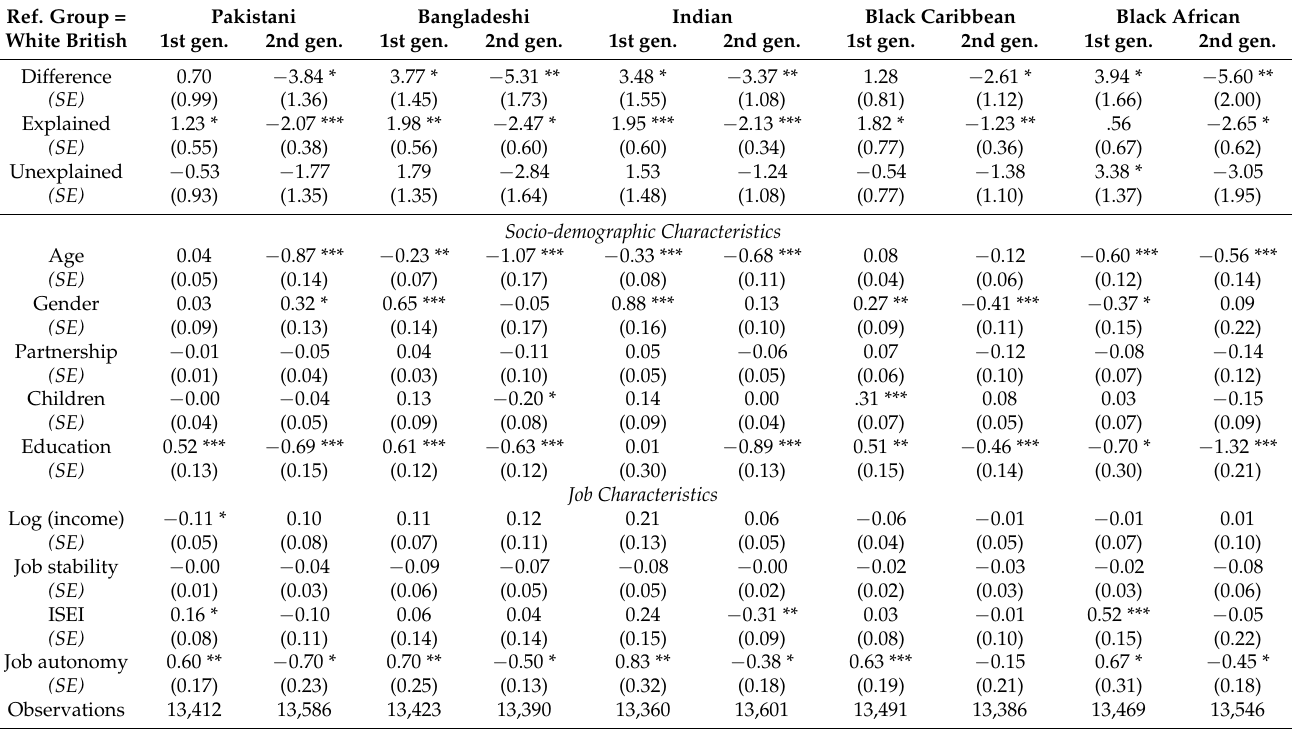
Table 3. Blinder-Oaxaca Decomposition Models of Intrinsic Work